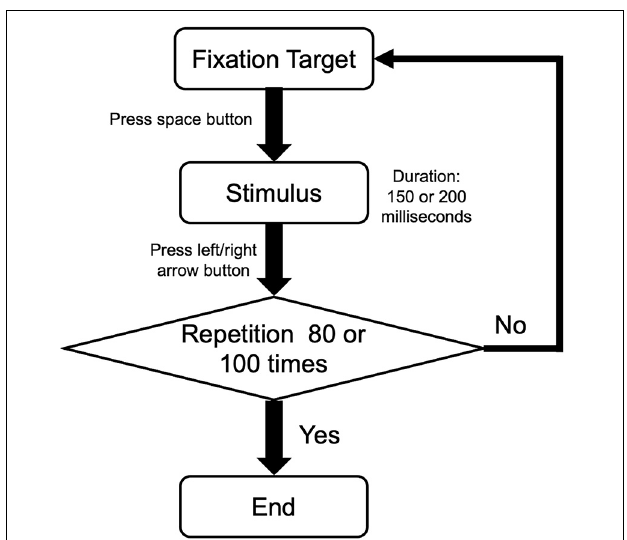
FIGURE 2 | The procedure of a single task in orientation and motion directions. Participants performed a two-alternative forced-choice task. After pressing the space button, participants pressed the left or right button according to the orientation of Gabor patches or the motion direction of random dots. Then, the procedure was repeated 80 times for orientation task and 100 times for motion direction